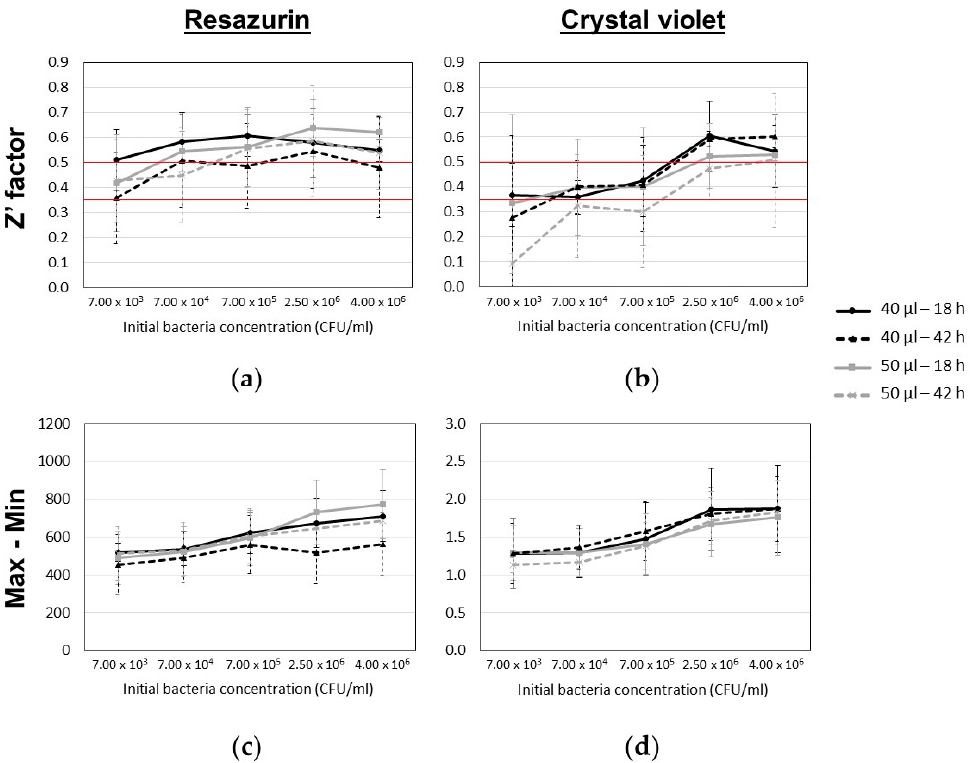
Figure 1. Effect of different initial S. aureus concentrations and working volumes on the performance of a miniaturized biofilm screening assay in 384WP. Assay performance is measured using the Z’ factor ( a , b ) and the maximum minus minimum signal ( c , d ) of the resazurin and crystal violet staining of S. aureus biofilms grown for 18 h or 42 h in a volume of 40 µL or 50 µL with different initial bacterial concentration in 384WP. Maximum minus minimum results are expressed in relative fluorescence units (RFUs) for resazurin or relative absorbance units (RAUs) for crystal violet. The results are based on 2–4 independent biological replica experiments, each plate containing 28–40 technical replicates for each condition and 30 media control replicates. The red lines in panels a and b represent the thresholds for determination of the quality of the assay: acceptable (Z = 0.35) and good (Z = 0.5).